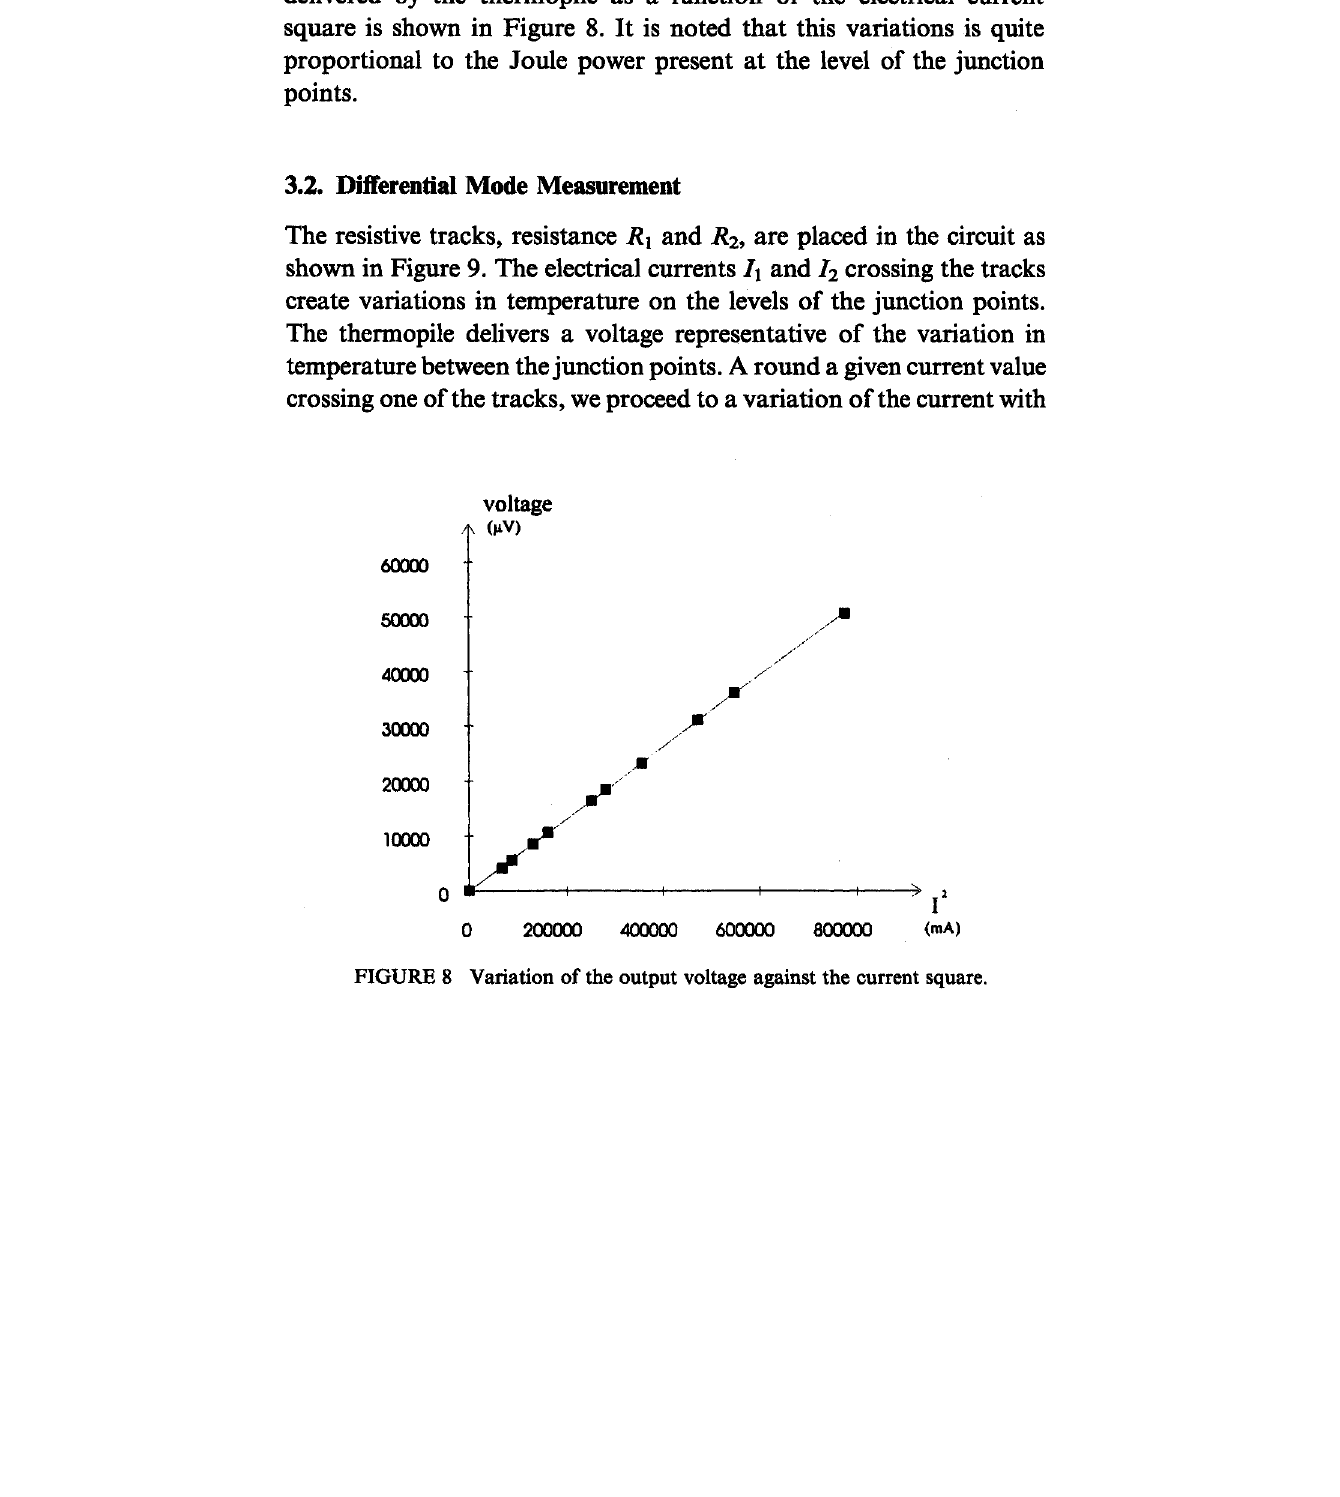
FIGURE 8 Variation of the output voltage against the current